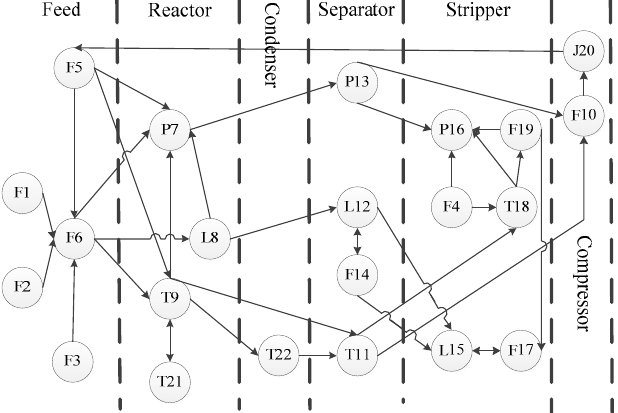
Figure 14. Graphical scenario object model of the TE process based on ontology.